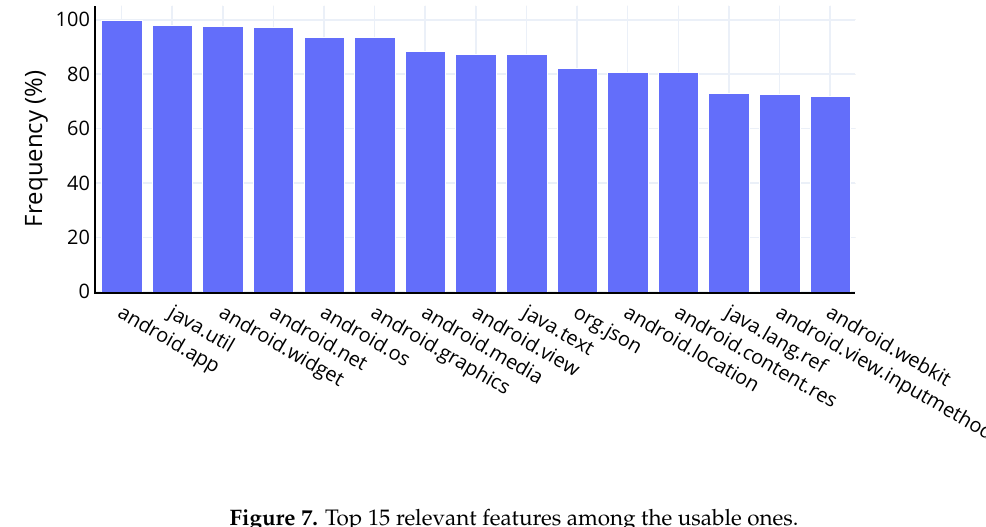
Figure 7. Top 15 relevant features among the usable